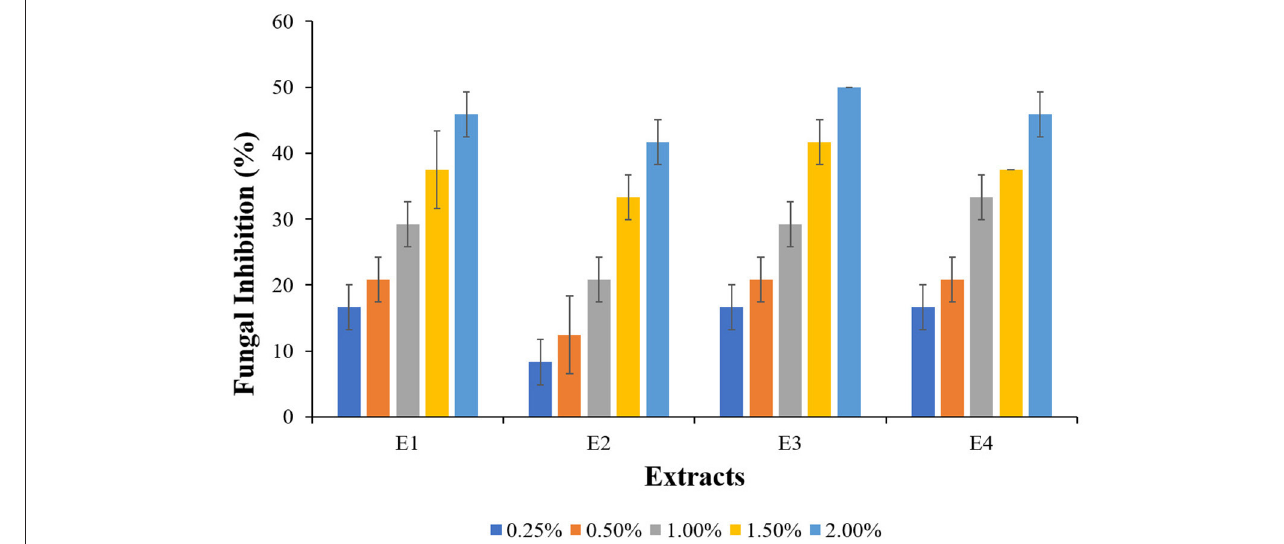
FIGURE 4 | Fungal inhibition in plant extracts treated wood blocks of Lannea coromandelica .